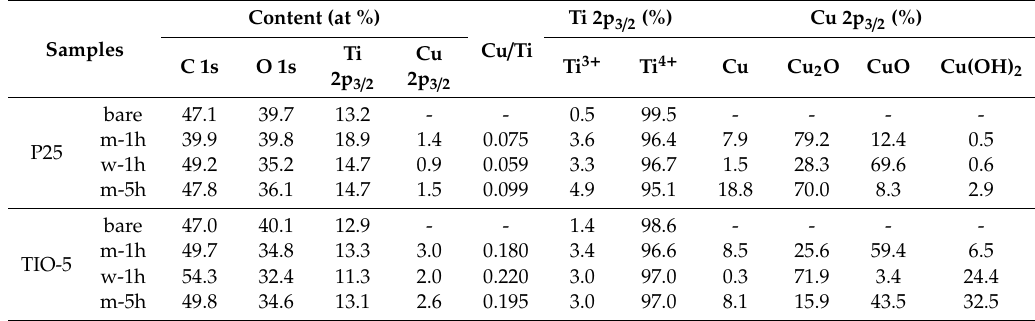
Table3. SurfacecompositionofsamplesdeterminedbyX-rayphotoelectronspectroscopy(XPS)analysis.